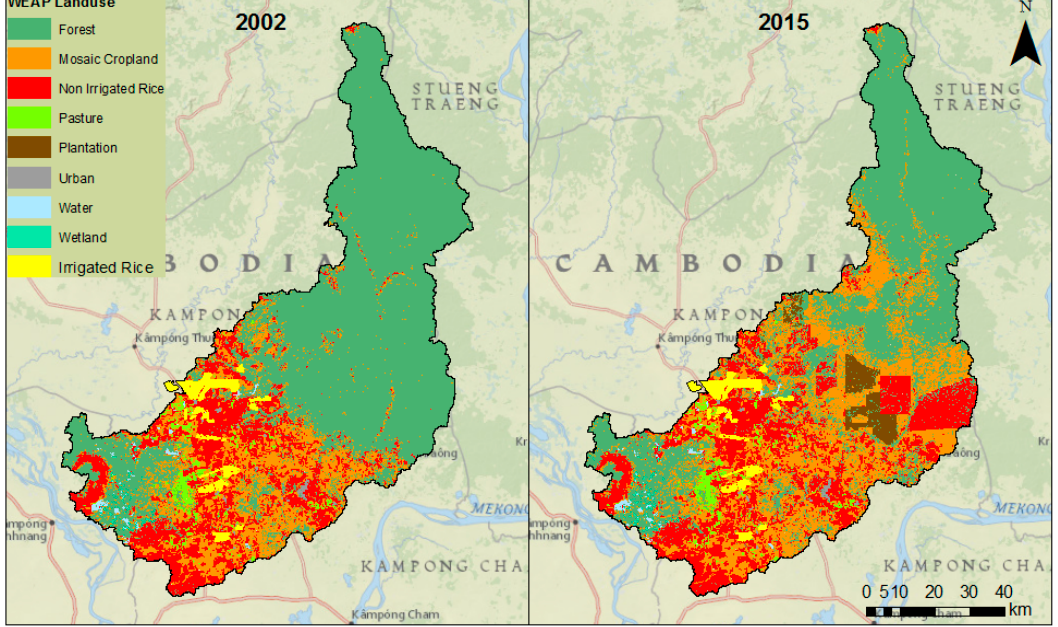
Figure 3. Land use in 2002 and 2015, colored by WEAP land use categories.